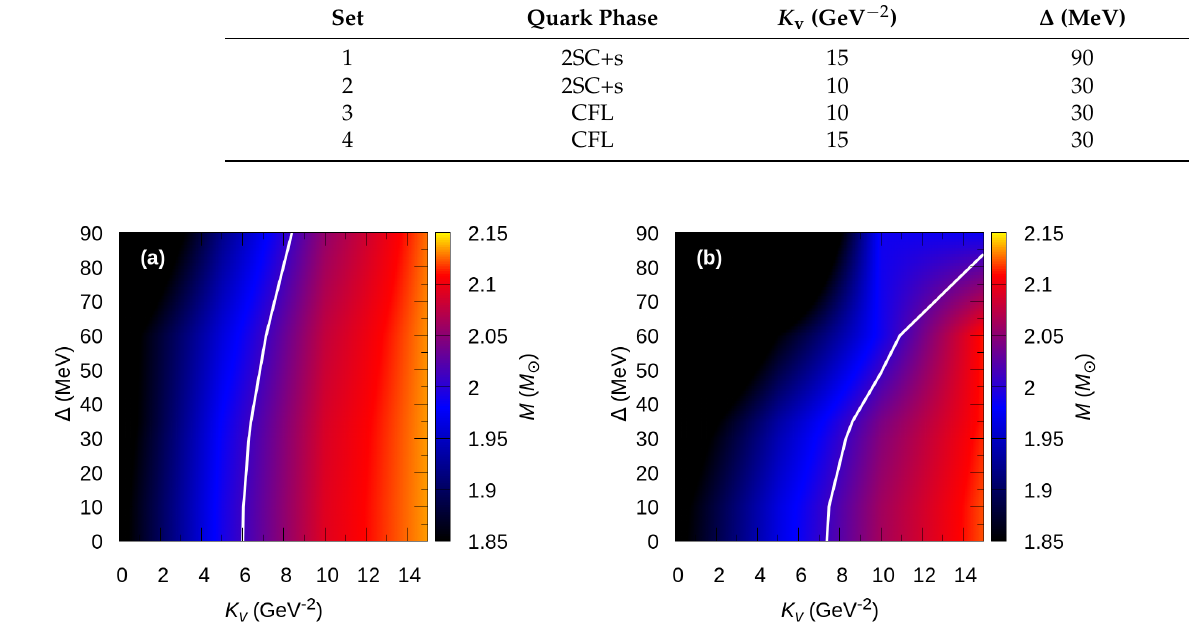
Table 4. Selected sets of parameters for the quark matter EoS.